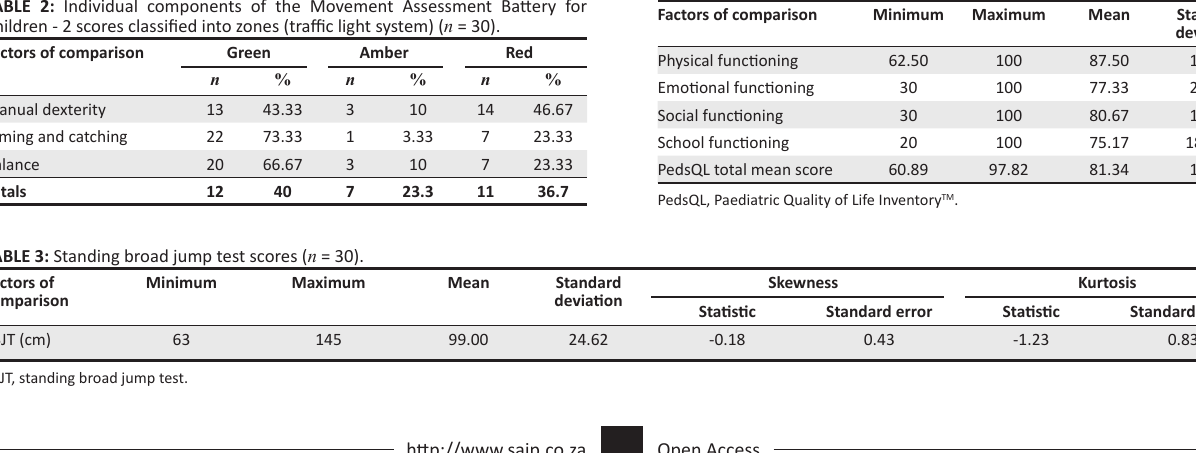
TABLE 4: Paediatric Quality of Life Inventory TM results ( n = 30).